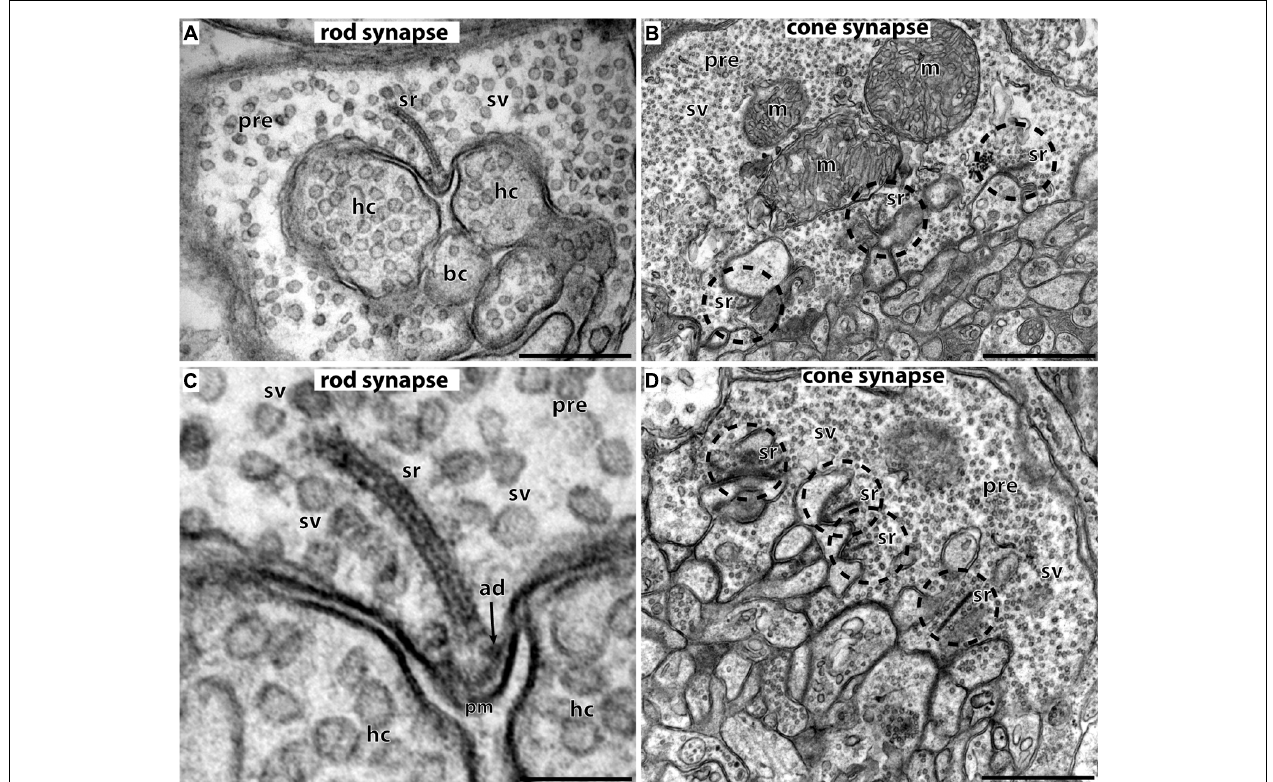
FIGURE 2 | Photoreceptor ribbon synapses. In (A,C) rod photoreceptor ribbon synapses are shown by transmission electron microscopy; in (B,D) cone photoreceptor ribbon synapses. (A,B) The large presynaptic terminals are filled with numerous synaptic vesicles (sv).The active zone is characterized by specialized presynaptic densities, the arciform densities (ad). The synaptic ribbon (sr) is anchored to the arciform density.The synaptic ribbon is associated with large numbers of synaptic vesicles. Opposite to the active zones are the dendritic tips of horizontal cells (hc) and bipolar cells (bc)